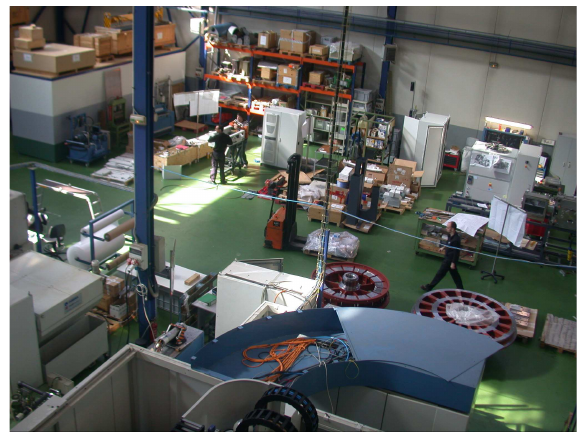
Figure 8. Manufacturing plant at IK4-TEKNIKER.